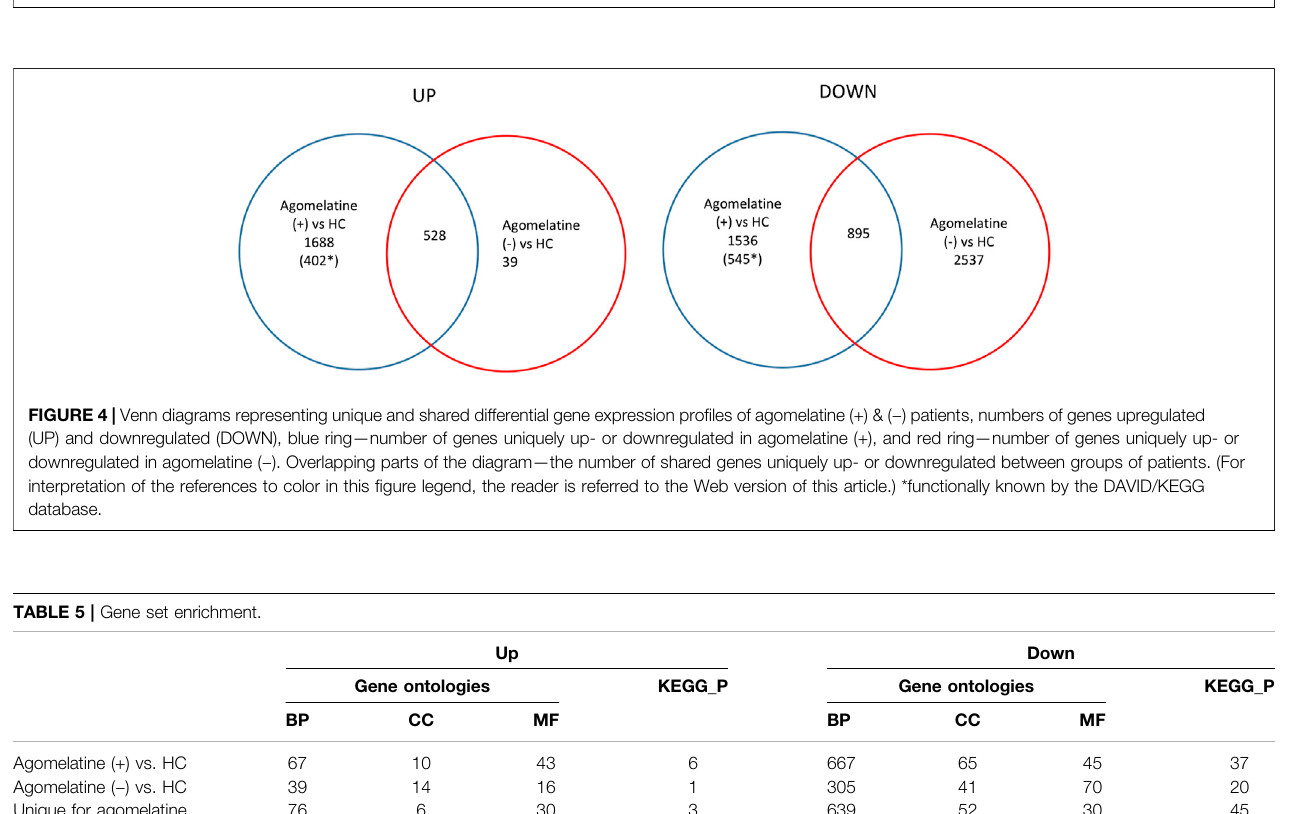
FIGURE 3 | Differences of MEL and AANAT serum level between AANAT rs3760138 genotypes.